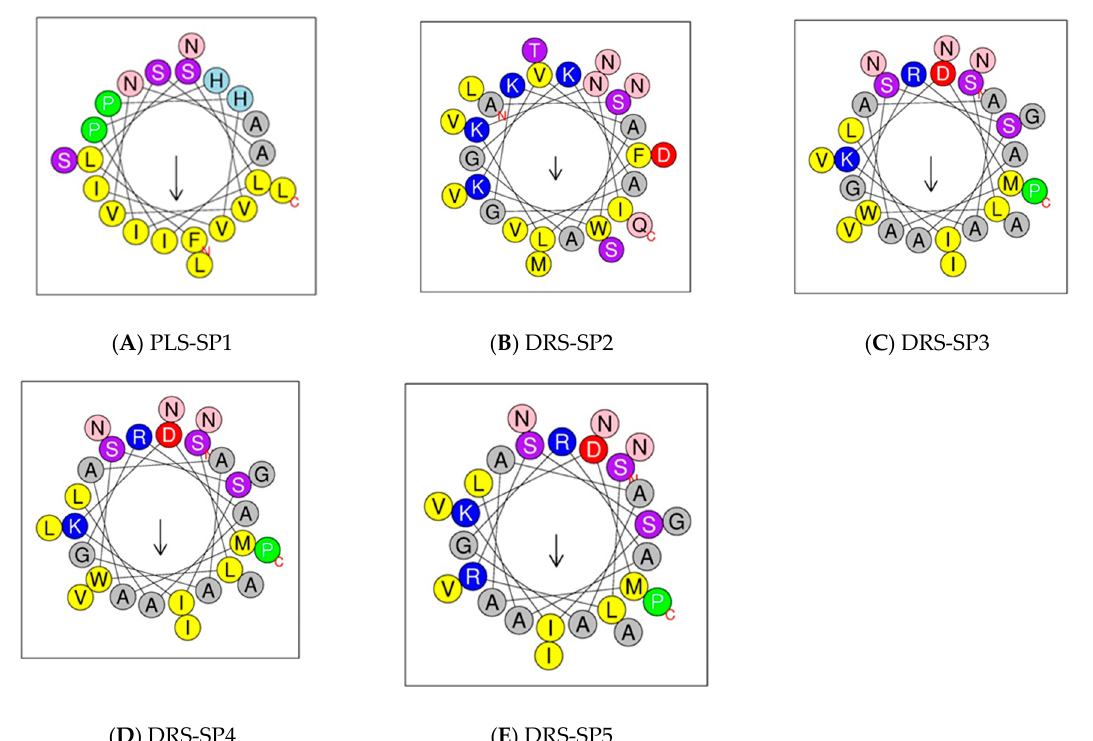
Figure 6. Helical wheel projections of the phylloseptins and dermaseptins-SP of A. spurrelli . Helical wheel projections of phylloseptin-SP1 ( A ), Dermaseptin-SP2 ( B ), Dermaseptin-SP3 ( C ), Dermaseptin-SP4 ( D ), and Dermaseptin-SP5 ( E